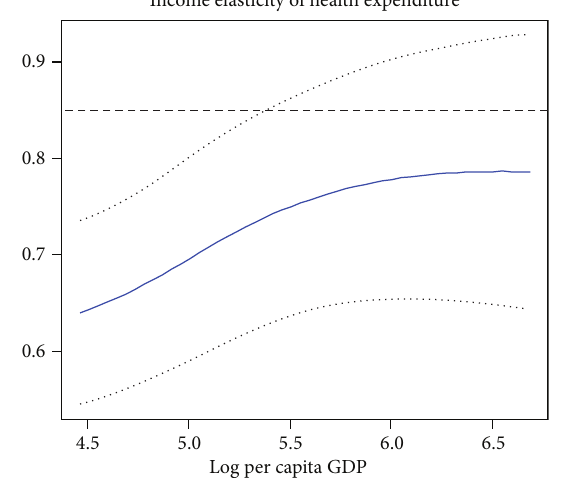
Figure 2: The income elasticity estimator of lower income African countries,thesolidcurvesrepresents 𝑚 󸀠 ( lnGDP ) . Thedottedcurves correspond to its 95% confidence interval. The level dashed line represents the estimate from the linear model.